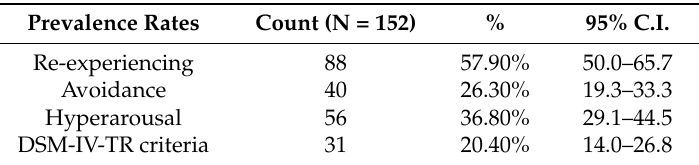
Table 1. Prevalence rates of child post-traumatic stress disorder (PTSD).